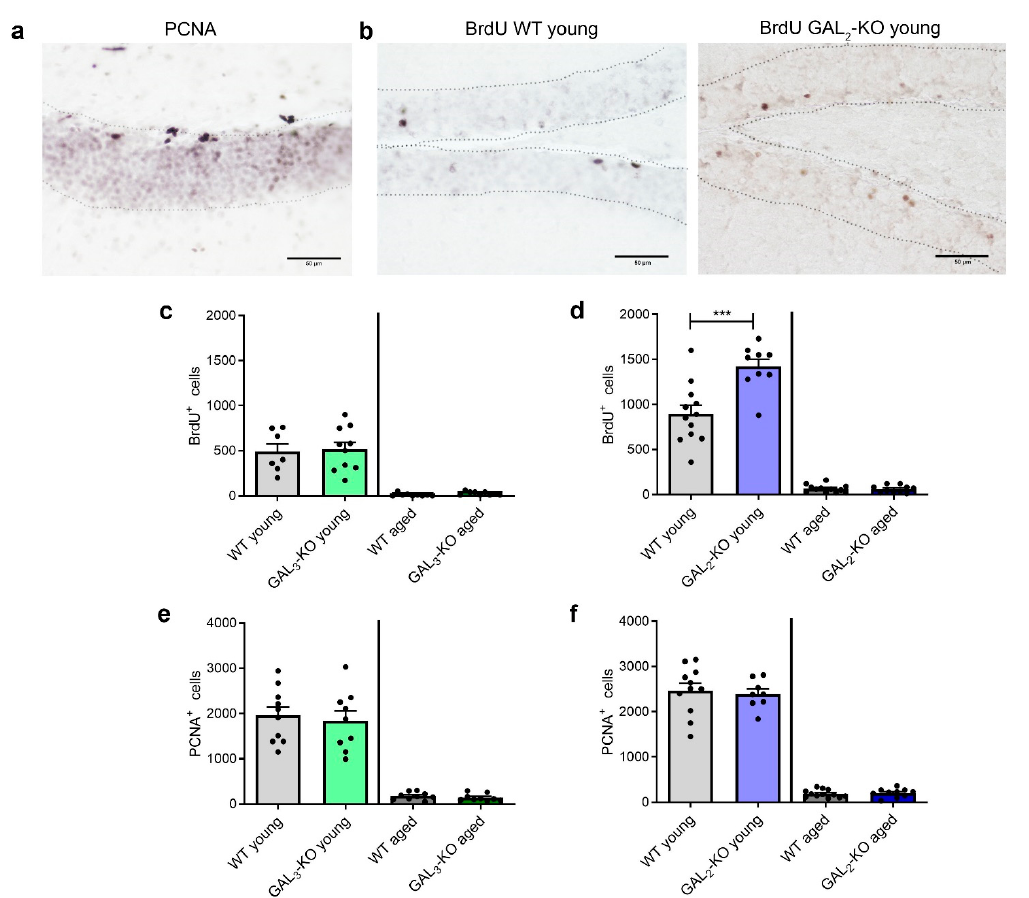
Figure 4. Immunohistochemical analyses of BrdU + and PCNA + cells in the DG. Representative micrographs of PCNA staining ( a ) in the DG of a 3-month-old mouse (C57BL/6N) and BrdU staining ( b ) of young WT and GAL 2 -KO mice (C57BL/6J). ( c ) Estimated numbers of BrdU + cells in the DG of GAL 3 -KO and corresponding WT mice 28 days after the start of the experiment (WT: n = 10; other groups: n = 9). ( d ) Estimated numbers of BrdU + cells in the DG of GAL 2 -KO and correspond- ing WT mice (WT young, WT aged: n = 12; GAL 2 -KO young: n = 9; GAL 2 -KO aged: n = 10). ( e ) Estimated numbers of PCNA + cells in the DG of GAL 3 -KO and corresponding WT mice (WT: n = 10; other groups: n = 9). ( f ) Estimated numbers of PCNA + cells in the dentate gyrus of GAL 2 -KO and corresponding WT mice (WT young: n = 11; WT aged: n = 12; GAL 2 -KO: n = 8; GAL 2 - KO aged: n = 10). Values are presented as mean ± SEM, *** p < 0.001; scale bar = 100 µm. BrdU: Bromodeoxyuridine; PCNA: proliferating cell nuclear antigen; GAL 2 -KO: GAL 2 -knockout; GAL 3 -KO: GAL 3 -knockout; WT: Wildtype.